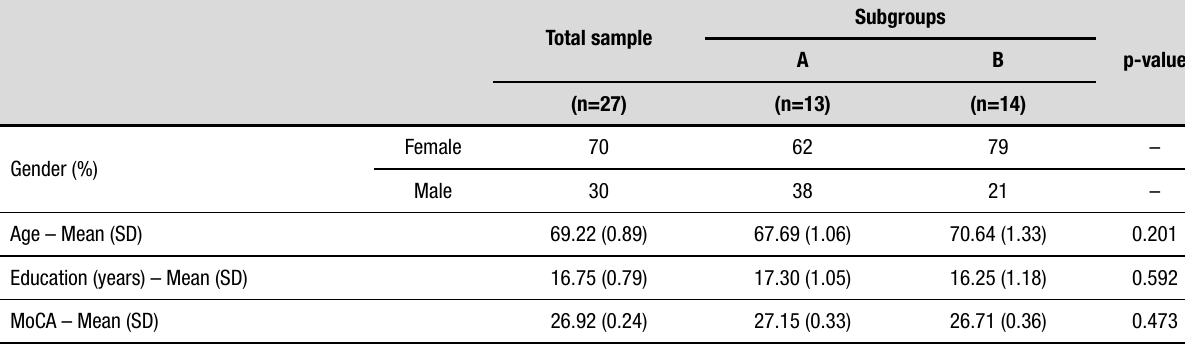
Table 1. Demographic and scores on cognitive screening of total participants and subgroups A and B.